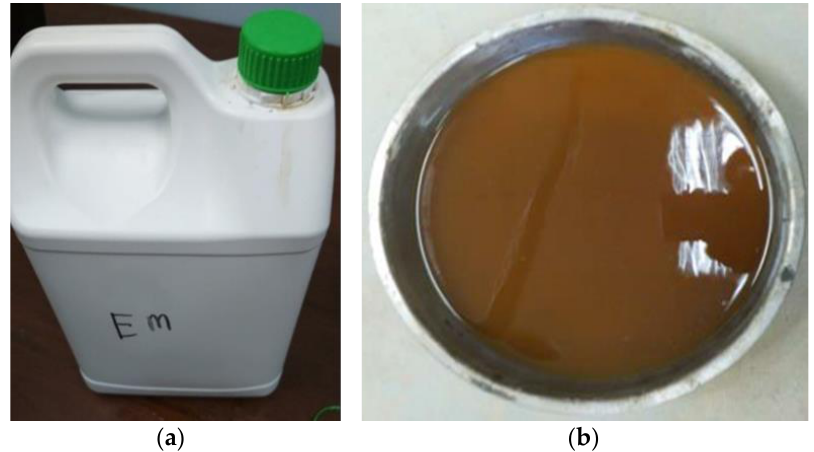
Figure 3. Ems solution ( a ) EMs-1 ( b ) EM substituted with 10% water. Table 2. Obtained values of viscosity coefficient, pH, and surface tension of EMs–water mix. Solution